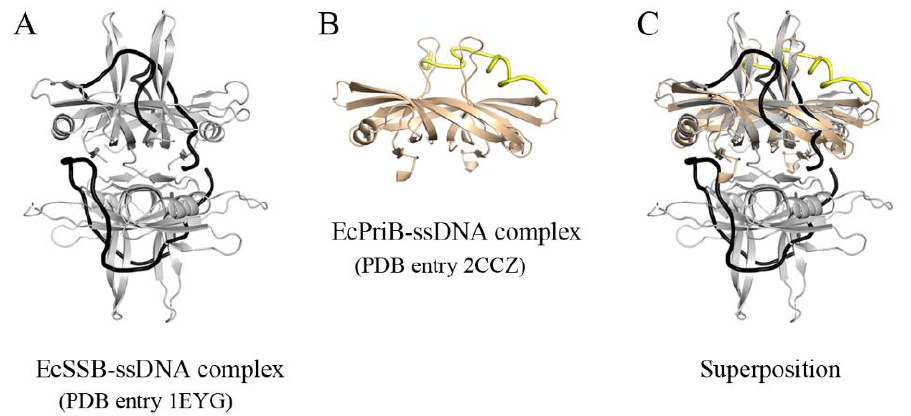
Figure 1. Structural comparison of EcSSB and EcPriB. ( A ) Crystal structure of EcSSB complxed with ssDNA. ( B ) Crystal structure of EcPriB complexed with ssDNA. ( C ) The superimposed structures. The crystal structures reveal that ssDNA wraps around SSB in a binding topology resembling seams on a baseball, while ssDNA adopts an Ω -shaped conformation to bind to the one monomer of the PriB dimer. ssDNAs bound by EcSSB and EcPriB are colored in black and yellow respectively.